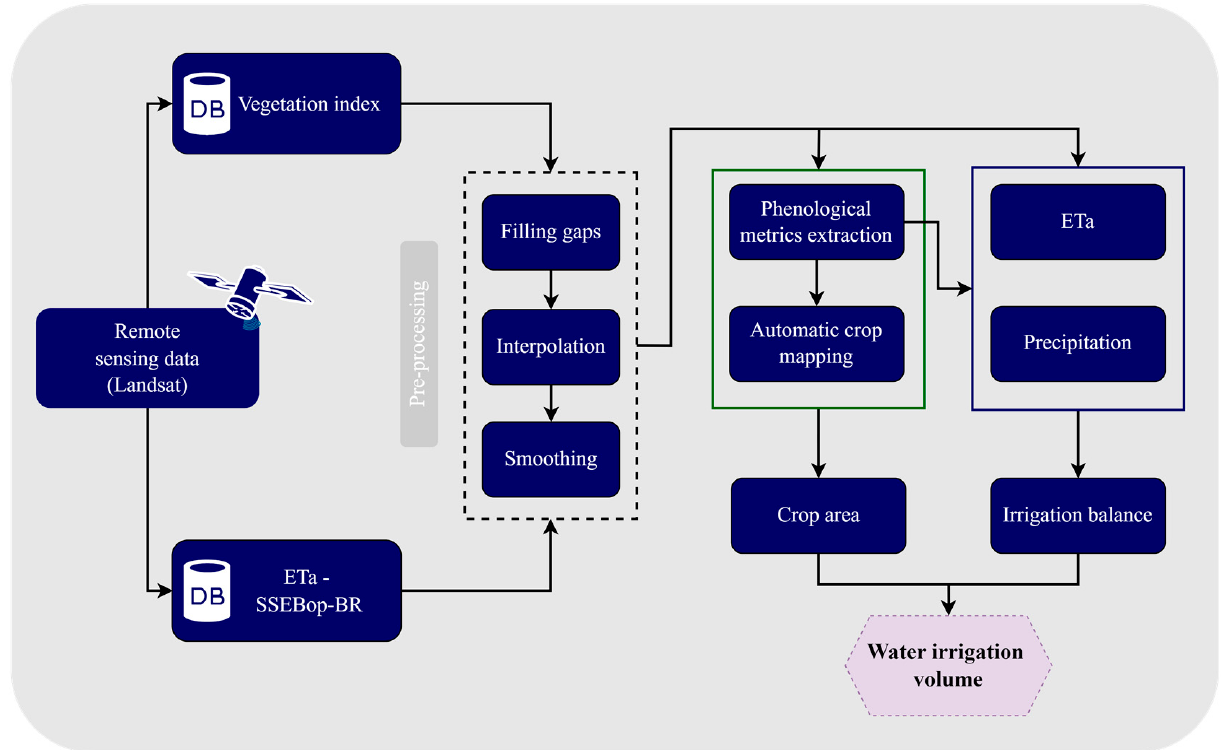
Figure 2. General scheme of the methodology used to estimate water use in irrigation. The dashed rectangle indicates the pre-processing steps of the time series (ETa and EVI). The green rectangle indicates the processes for obtaining the crop area. The blue rectangle indicates the process of ETa and precipitation accumulation according to cycle duration based on phenological metrics.